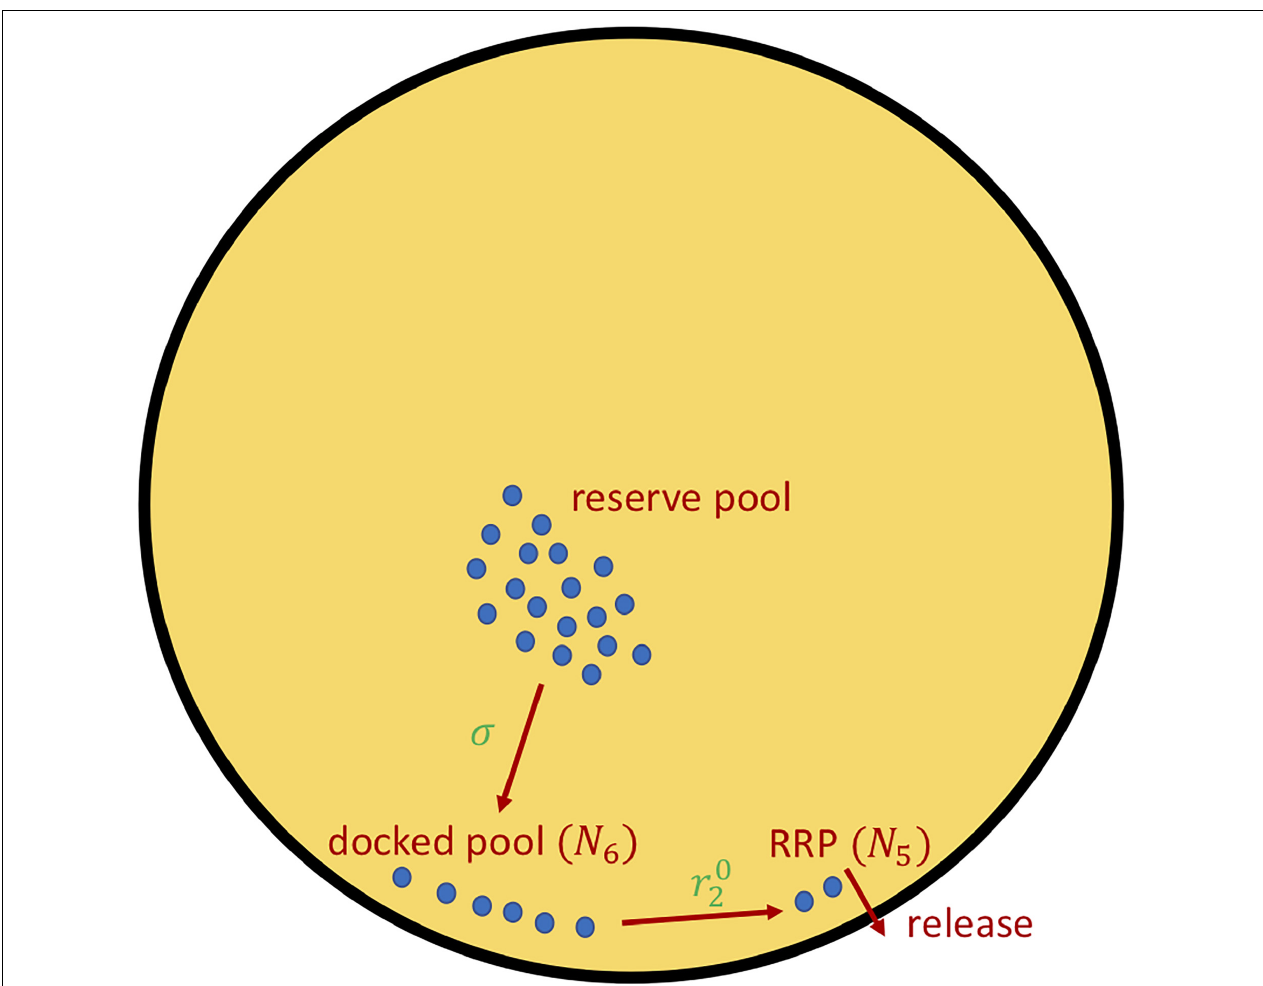
FIGURE 1 | The insulin secretion rate, ISR (Eq. 5), can be decomposed into two components, delivery of granules from the reserved pool to the plasma membrane docked pool (variable N 6 ), with rate proportional to σ (Eqs. 6, 7), and the priming of docked granules into readily releasable pool (RRP; variable N 5 ) granules, with rate proportional to parameter r 0 2 (Eq. 8). The release steps correspond to the fast calcium-dependent binding steps (variables N 1 − N 4 ) as well as vesicle fusion and insulin release. For details see Eqs. A10–A12, Supplementary Table 8 in Supplementary Material —Equations and refs (Grodsky, 1972; Topp et al., 2000; Dalla Man et al., 2002; Chen et al., 2008; Ha et al., 2016; Ha and Sherman, 2020).